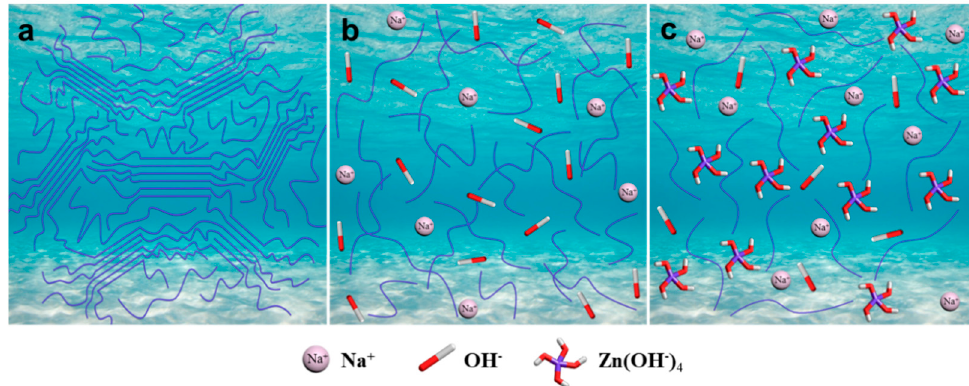
Figure 10. Schematic illustration for the dissolution mechanism of CC in ( a ) H 2 O, ( b ) NaOH/H 2 O, and ( c ) NaOH/ZnO/H 2